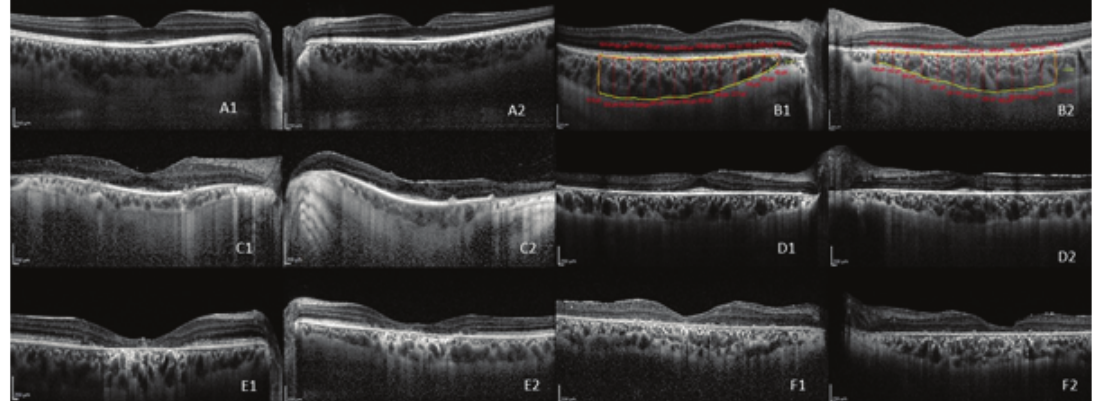
Figure 1. Representative enhanced depth imaging (EDI) of four different inherited retinal dystrophies and of a healthy control. A1: Right eye of a healthy control, A2: left eye of a healthy control B1, B2: Examples of choroidal thickness measurement manually and automatically in the right and the left eyes, respectively, of a healthy subject C1, C2: EDI of the right and the left eyes, respectively, of a patient with retinitis pigmentosa D1, D2: EDI of the right and the left eyes, respectively, of a patient with Usher syndrome E1, E2: EDI of the right and the left eyes, respectively, of a patient with Stargardt disease F1, F2: EDI of the right and the left eyes, respectively, of a patient with cone-rod dystrophy